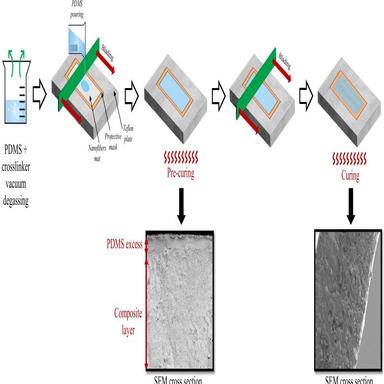
Integration steps of the P(VDF-TrFE-CTFE)-based nanofibers into a PDMS silicone elastomer. The nanofibers mat is placed on a teflon substrate and integrated in PDMS after two subsequent blading and curing steps. The SEM images show the integrated nanofibers with and without an excess of PDMS (i.e., before and after the second blading).